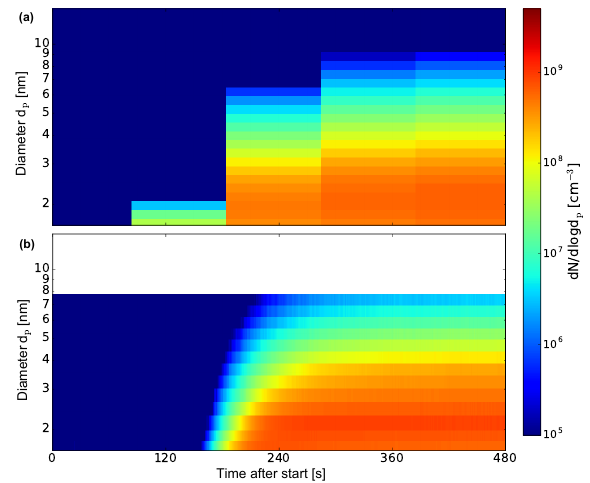
Figure 10. Evolution of the size distribution measured by a conven- tional DMPS (a) and the DMA-train (b) of a tungsten oxide gen- erator during warmup. The generator is switched on a time 0. The DMA-train uses its maximum resolution of 1s while the DMPS bins are placed between start and stop of the scanning cycle.